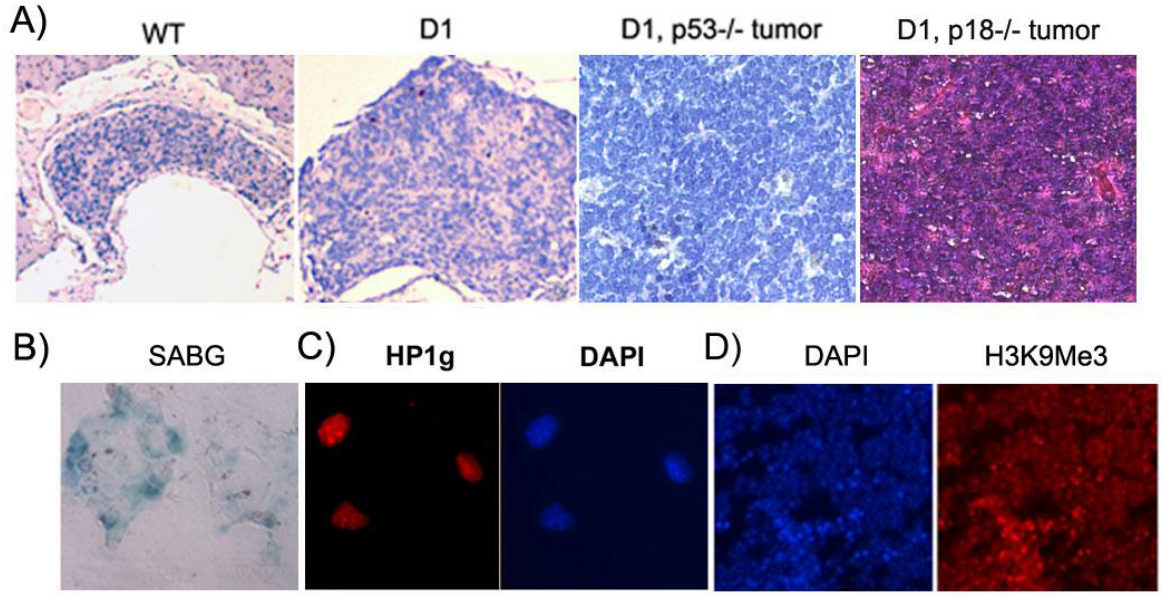
FIGURE 2. Features of senescence in vivo and in vitro . (A) H&E-stained sections of pineal glands from wild-type (WT), transgenic Irbp- Cyclin D1 (D1) mice expressing Cyclin D1 in the pineal cells, resulting in premalignant “senescent” hyperplastic lesions, and pineal tumor progression in D1 mice in the absence of p53 (D1p53–/–) or p18Ink4c (D1p18–/–). (B) Staining of cultured Irbp-Cyclin D1 pineal cells with β- galactosidase at acidic pH shows SABG-positive staining consistent with a senescent phenotype. (C) SAHF, shown by staining for HP1γ in Irbp-Cyclin D1 pineal cells in culture and (D) in vivo by staining for H3K9-me3 foci, in Irbp-Cyclin D1 pineal gland